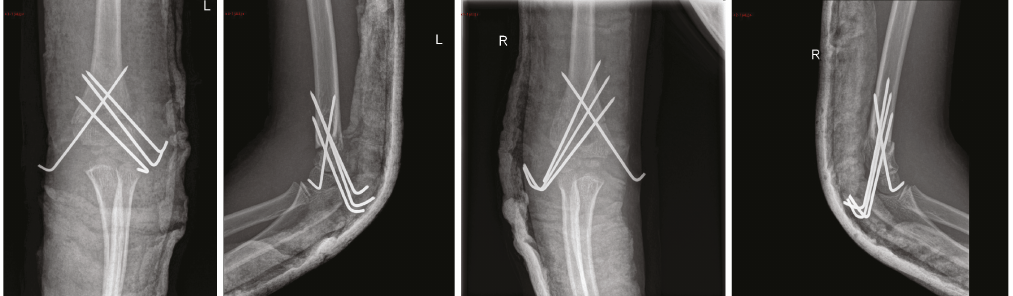
Figure 2: Day 1 post-op X-rays. AP and lateral views of the right and left elbows.